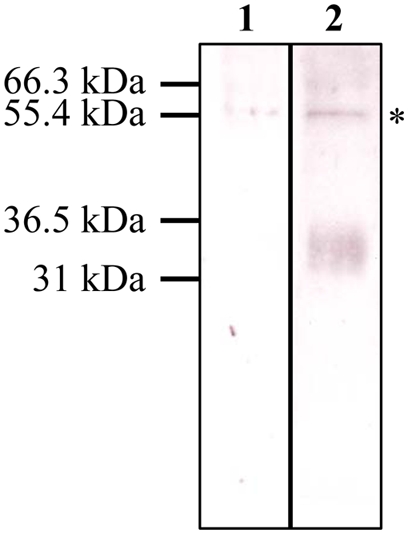
Western blot analysis of sera from repeatedly bitten rabbits.Five hundred nanograms of recombinant Ir-LBP were submitted to SDS-PAGE and analyzed by western blot using pooled serum from two naïve rabbits (lane 1) and rabbits infested three times by I. ricinus female ticks (lane 2). *: unspecific band.